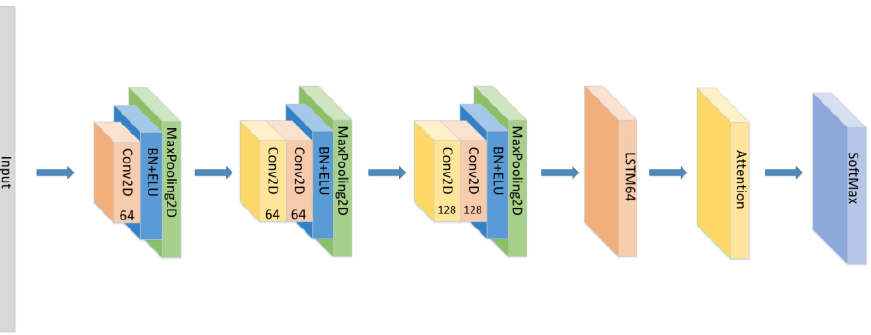
Figure 1. The detailed architecture of the proposed CNN+LSTM×2+attention model for speech emo- tion